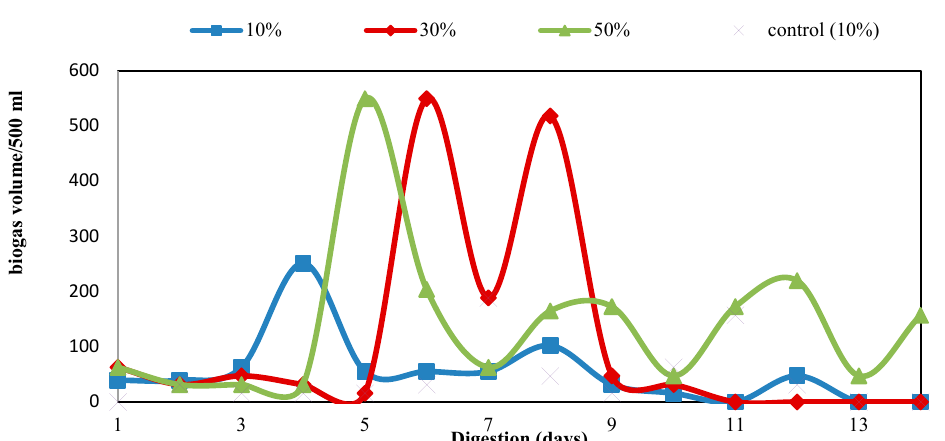
Figure 7. Biogas volume produced daily in each digester at HRT= 25 days, T = 37 °C. Digester volume of 500 mL and digestion time of 14 days.